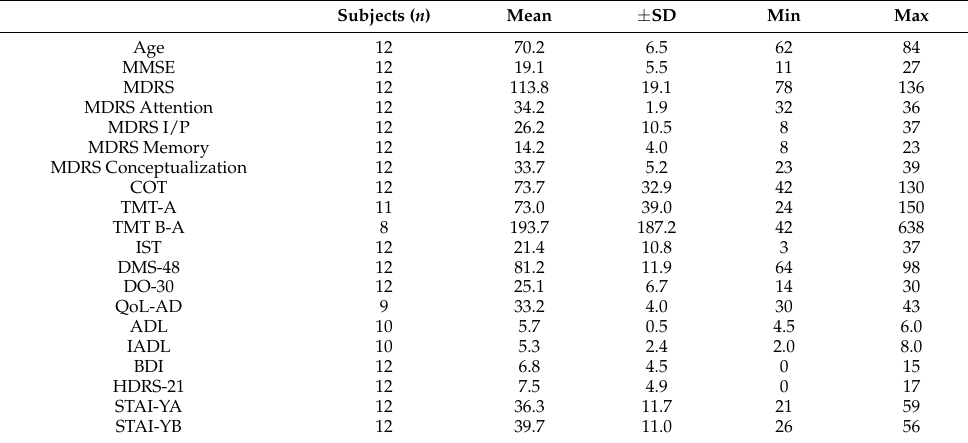
Table 1. Mean values, standard deviation (SD) and range scores (Min-Max) for demographic and baseline